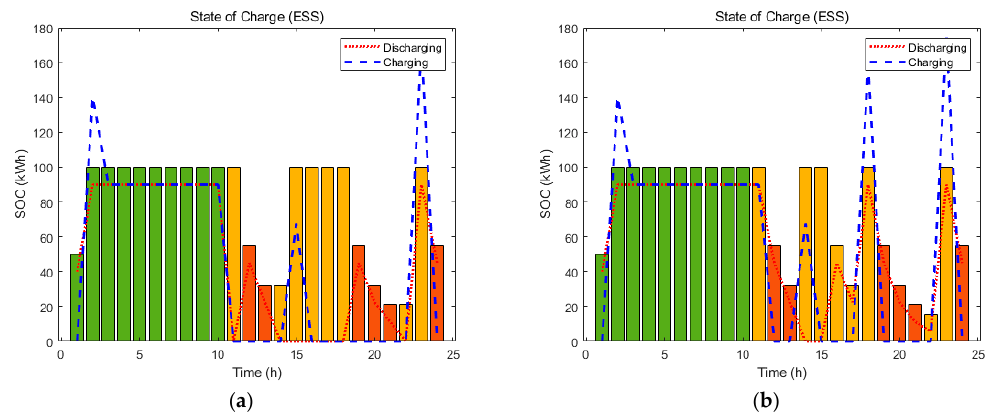
Figure 10. Optimal SOC of ESS scheduling results in winter: ( a ) Without DR; ( b ) with DR.